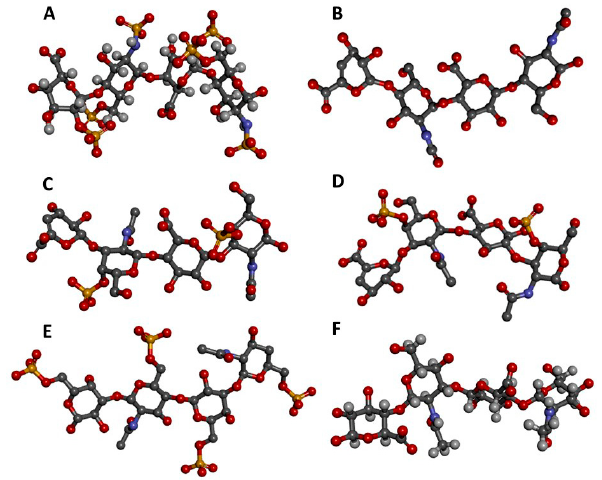
Figure 1. Three-dimensional tetrasaccharide representations, taken from files in the PDB as indicated, of: ( A ) Heparin [IdoA2S( α 1 → 4)GlcNS6S( α 1 → 4)IdoA2S( α 1 → 4)GlcNS6S] from 1HPN; ( B ) heparan sulfate [GlcA( β 1 → 4)GlcNAc( α 1 → 4)GlcA( β 1 → 4)GlcNAc] from 3E7J; ( C ) chondroitin 4-sulfate [GlcA( β 1 → 3)GalNAc4S( β 1 → 4)GlcA( β 1 → 3)GalNAc4S] from 1OFM; ( D ) dermatan sulfate [IdoA( α 1 → 3)GalNAc4S( β 1 → 4)IdoA( α 1 → 3)GalNAc4S] from 1OFL; ( E ) keratan sulfate [Gal6S( β 1 → 4)GlcNAc6S( β 1 → 3)Gal6S( β 1 → 4)GlcNAc6S] from 1KES; and ( F ) hyaluronan [GlcA( β 1 → 3)GlcNAc( β 1 → 4)GlcA( β 1 → 3)GlcNAc] from 2BVK. The atoms in the ball-stick representations are carbon (grey), nitrogen (blue), hydrogen (light grey); oxygen (red) and sulfur (yellow). A and F are NMR solution structures, and non-exchangeable protons are shown; the others are crystal structures so are shown without protons.